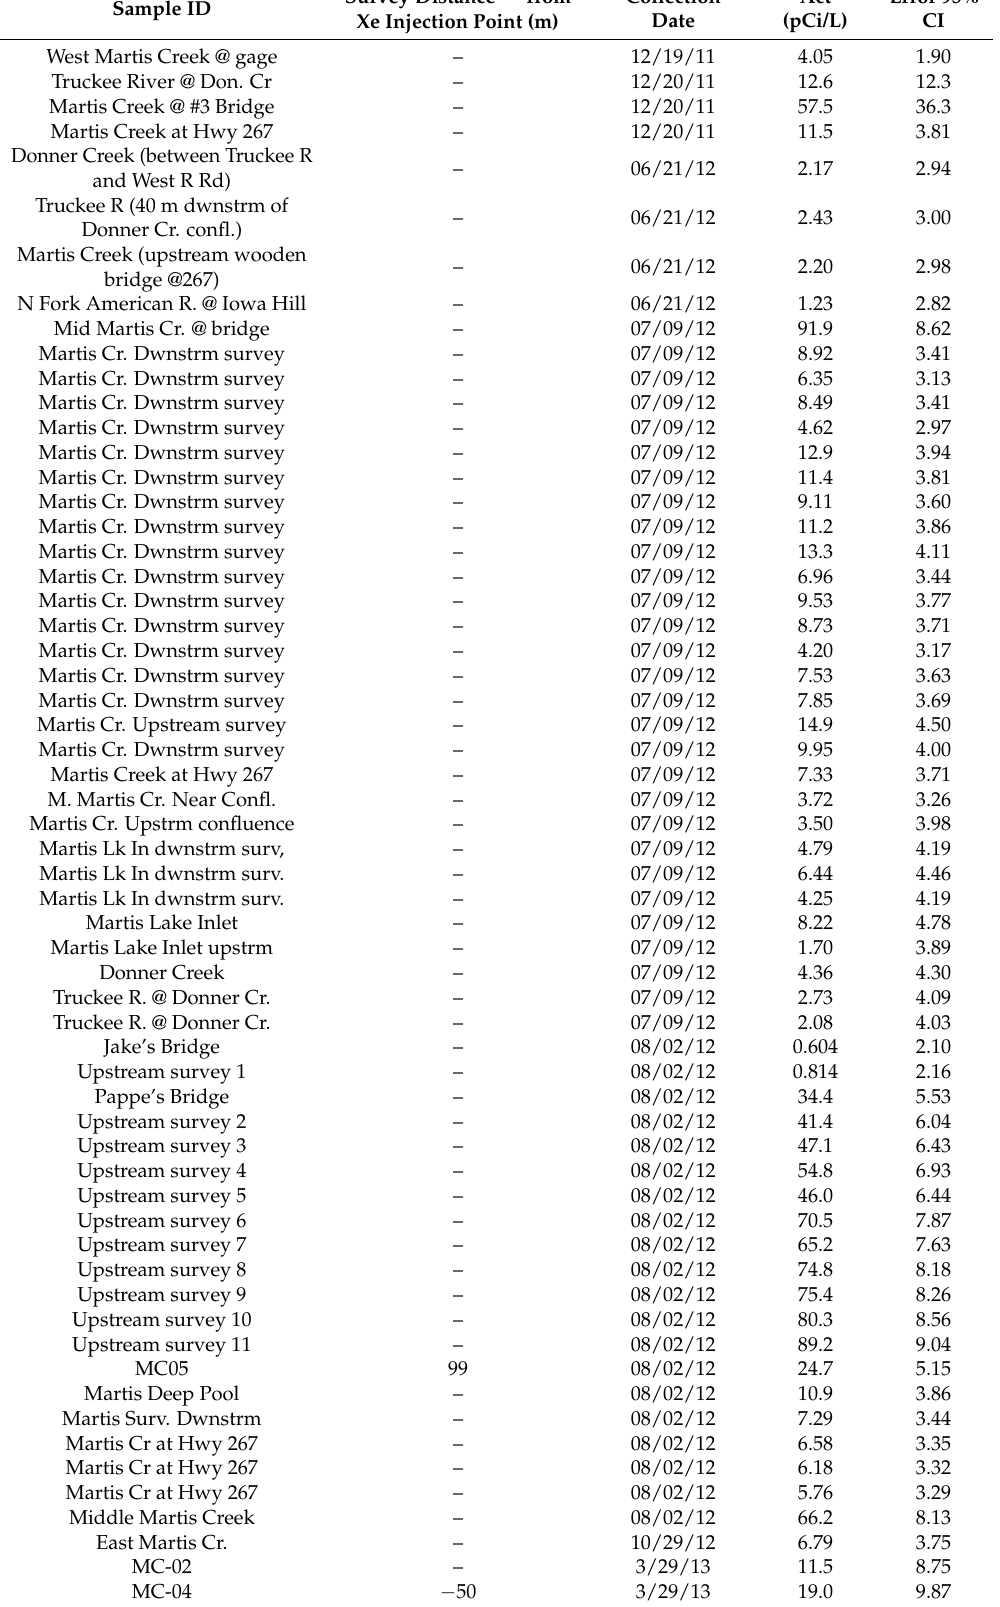
Table A2. Measured 222 Rn activity levels for surface water in the Martis Valley region. Survey Distance 1,2 Sample ID